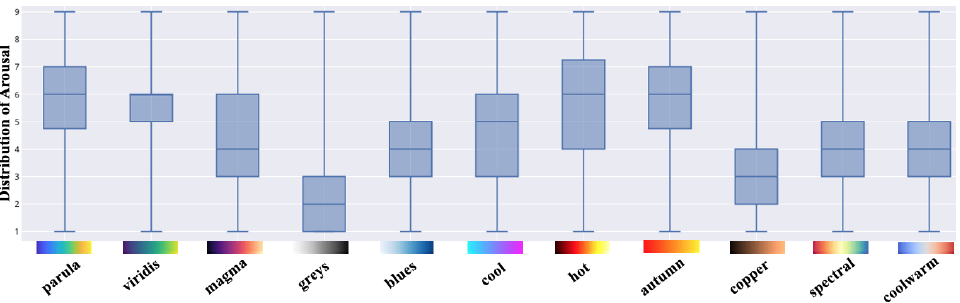
Figure 9. The individual distribution of the affect for the 11 colormaps in the dimension of